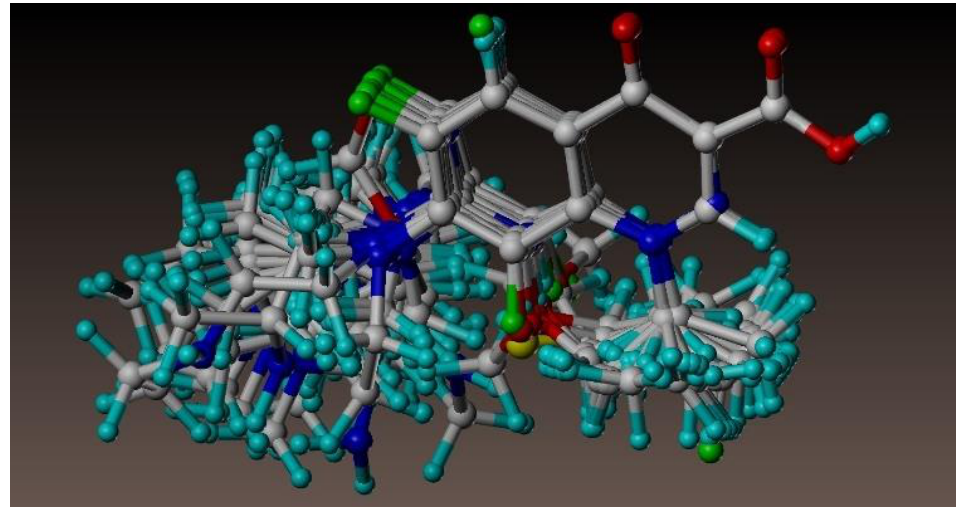
Figure 5. The result of all the molecules overlapping.